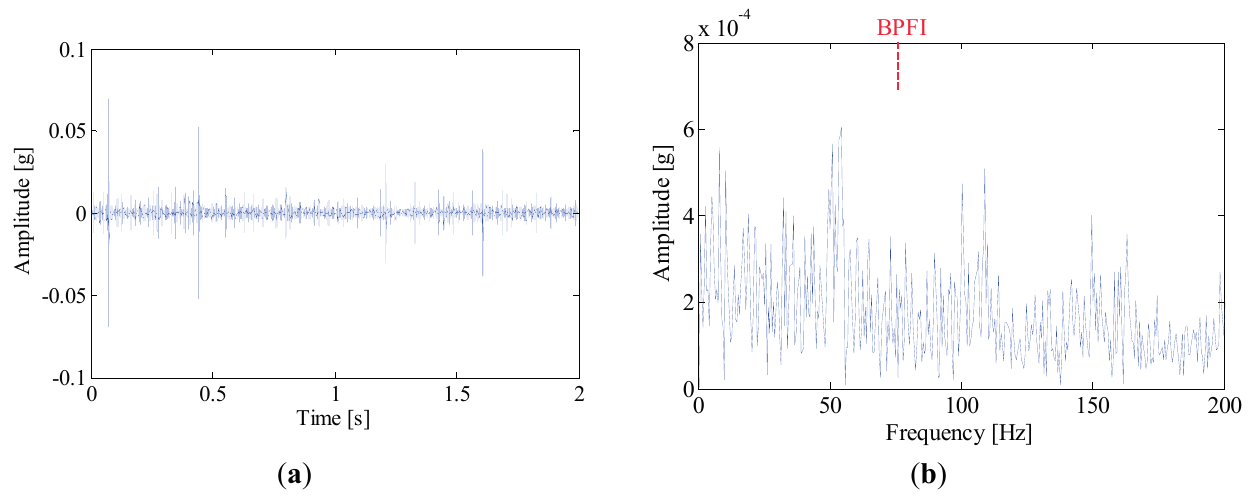
Figure 22. ( a ) Waveforms and ( b ) envelope spectrum of the band-pass filtered